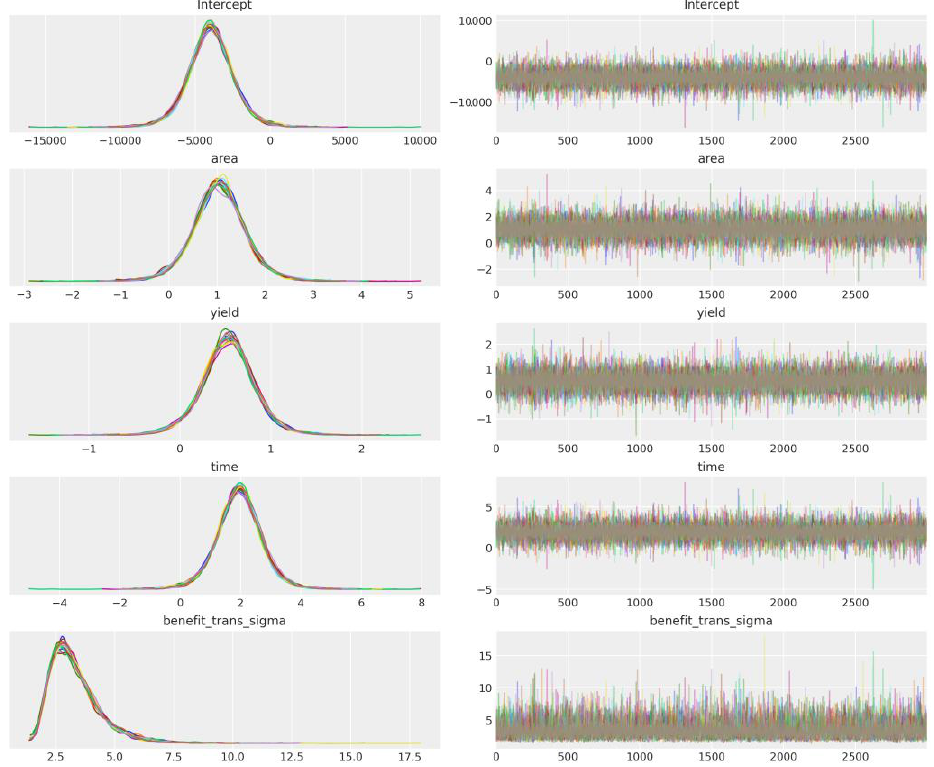
Figure A4. Model results and posterior distribution of effect size for all independent variables used in our analysis. Note that the variable “benefit_trans” indicates benefit in thousands of